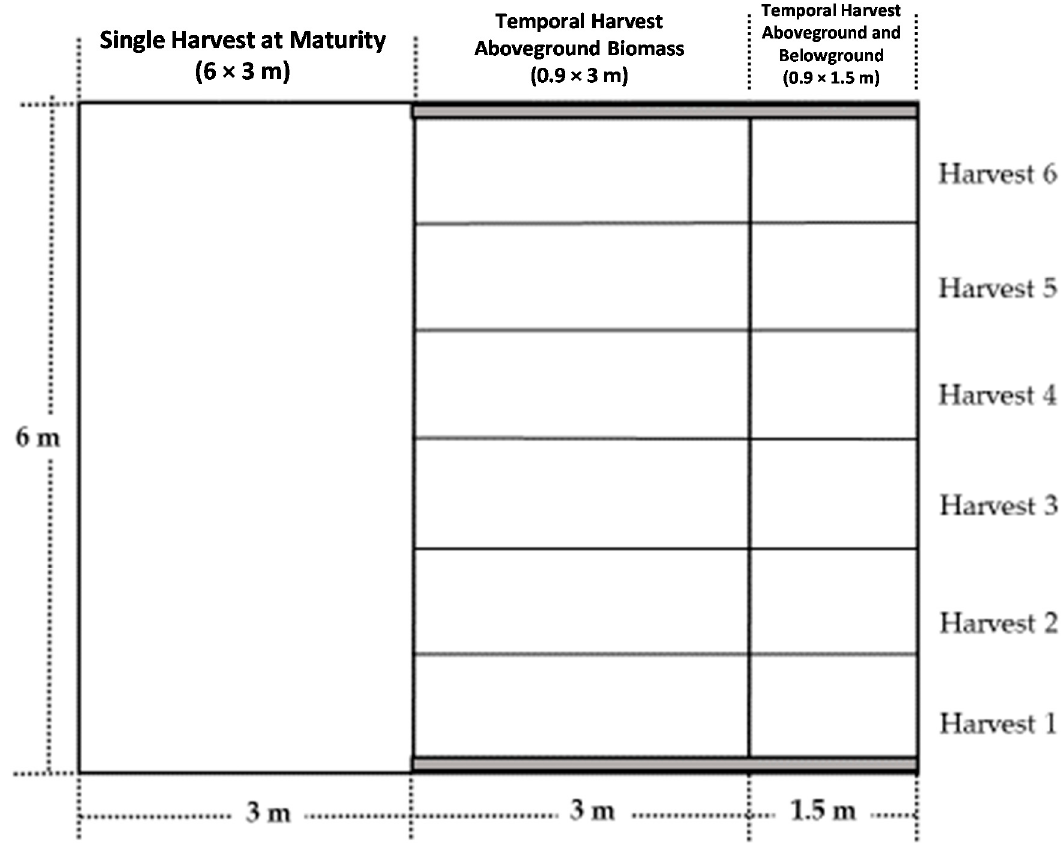
Figure 1. One of the four plots designed for harvest sampling. The plot measured 6 × 7.5 m.